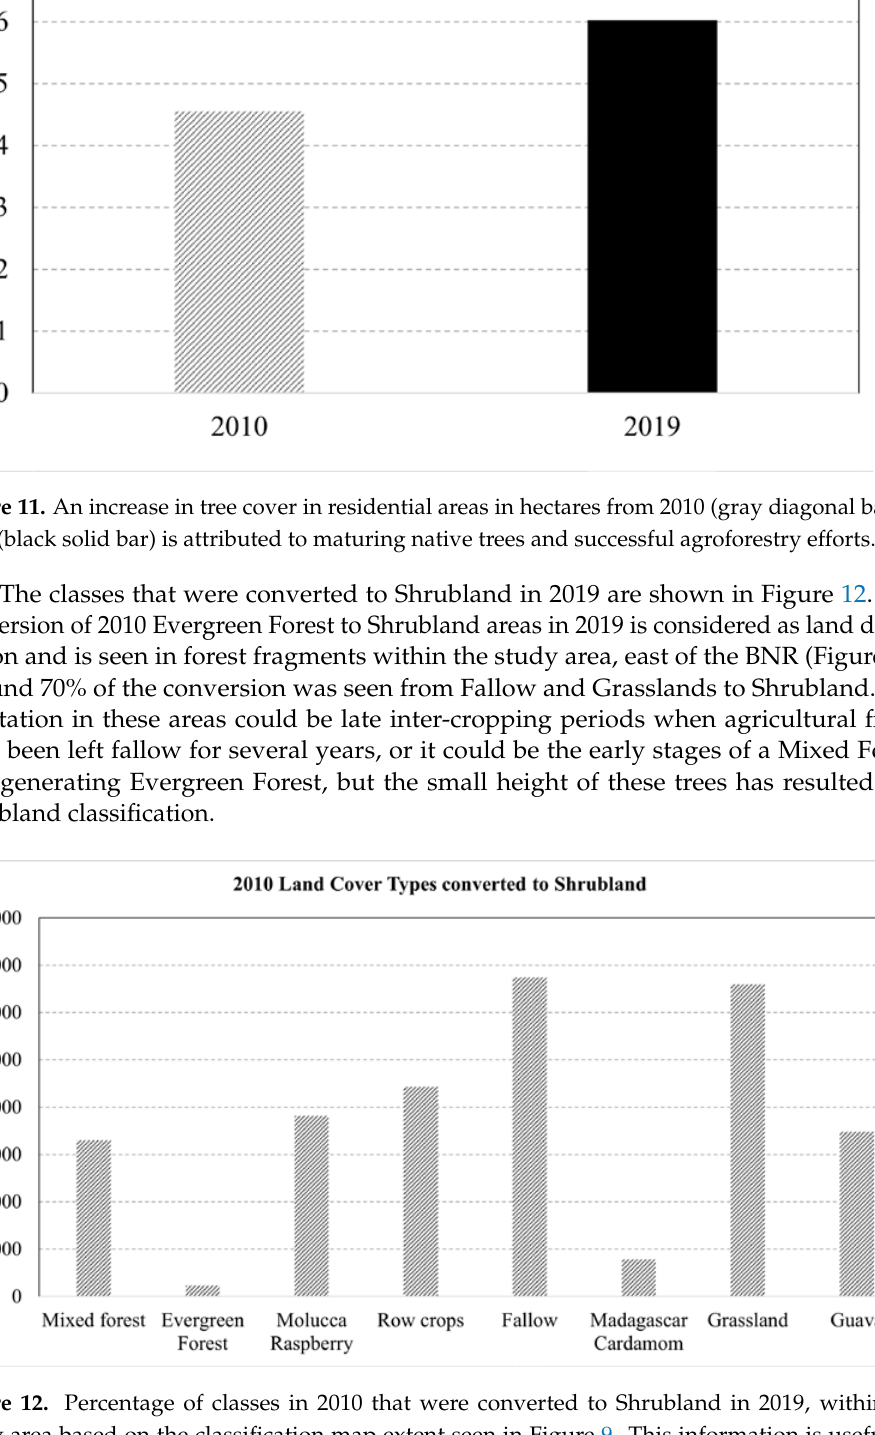
Figure 13. Evergreen Forest areas in 2010 (green boundary polygons) that were converted to Shrub- land in 2019 located east of the BNR, overlaid over the 2019 classification map. The inset map shows the 2019 classification map.